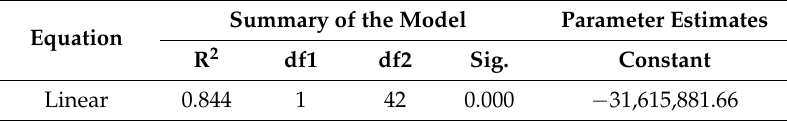
Table 12. Summary of Linear model.